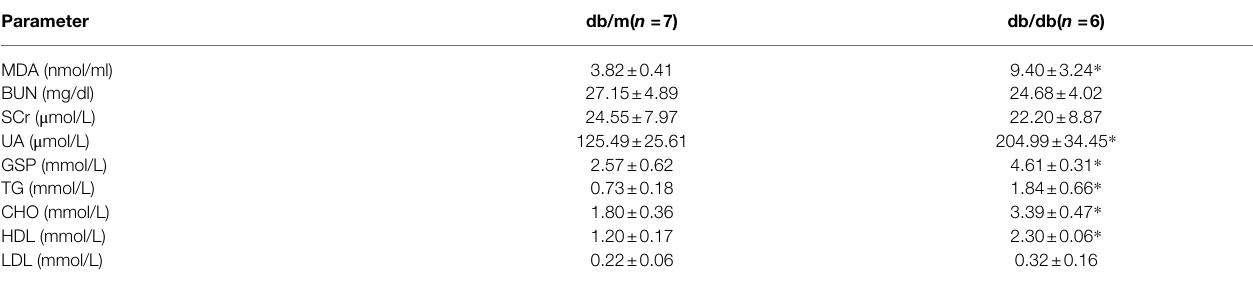
TABLE 1 | Serum biochemical parameters between db/m mice and db/db mice.